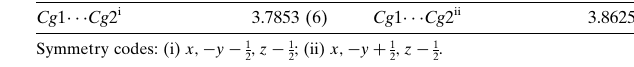
Selected centroid–centroid distances (A˚ ). Cg 1 and Cg 2 are the centroids of the C1 A –C6 A and C1 B –C6 B rings, respectively.